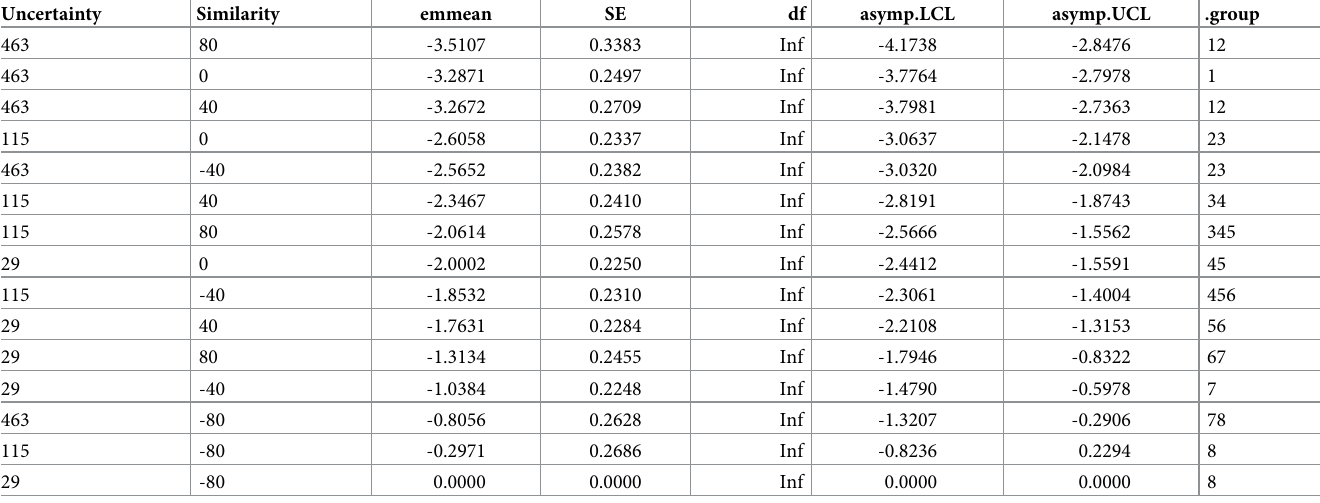
Table 4. Estimated marginal means and compact letter display for all-pairwise comparisons of the interaction between masker-target similarity and masker uncer- tainty in Experiment I. Uncertainty